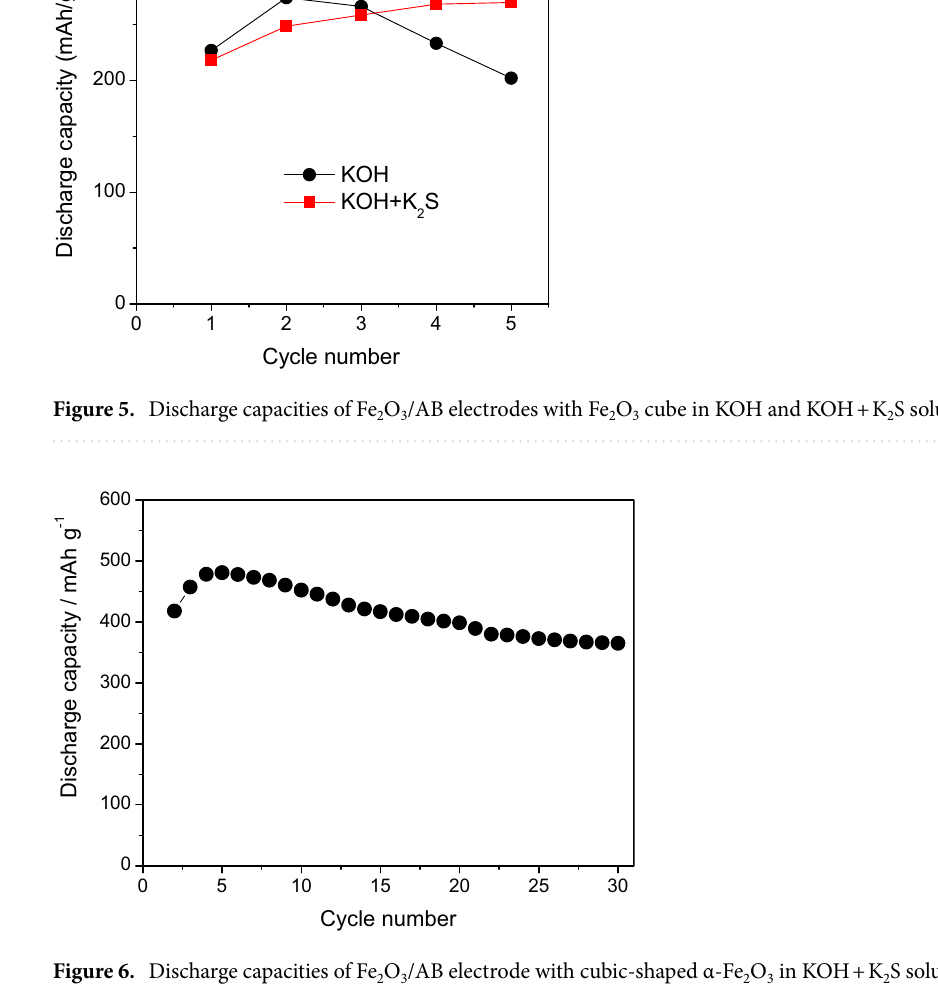
Figure 6. Discharge capacities of Fe 2 O 3 /AB electrode with cubic-shaped α-Fe 2 O 3 in KOH + K 2 S